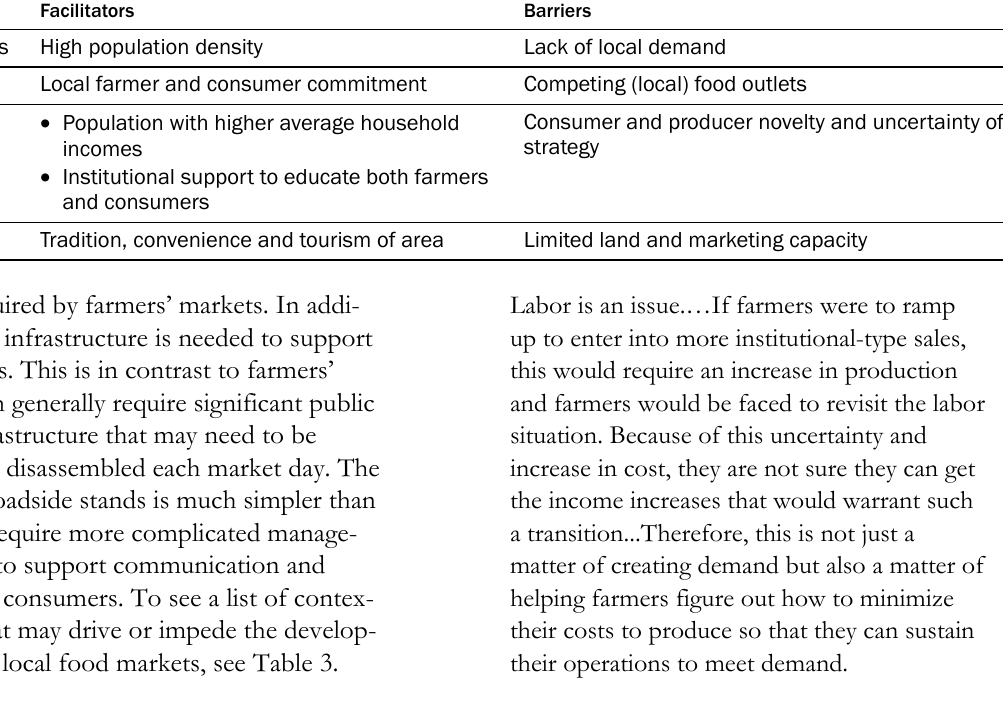
Table 3. Direct Markets: Development Barriers and Facilitators Market